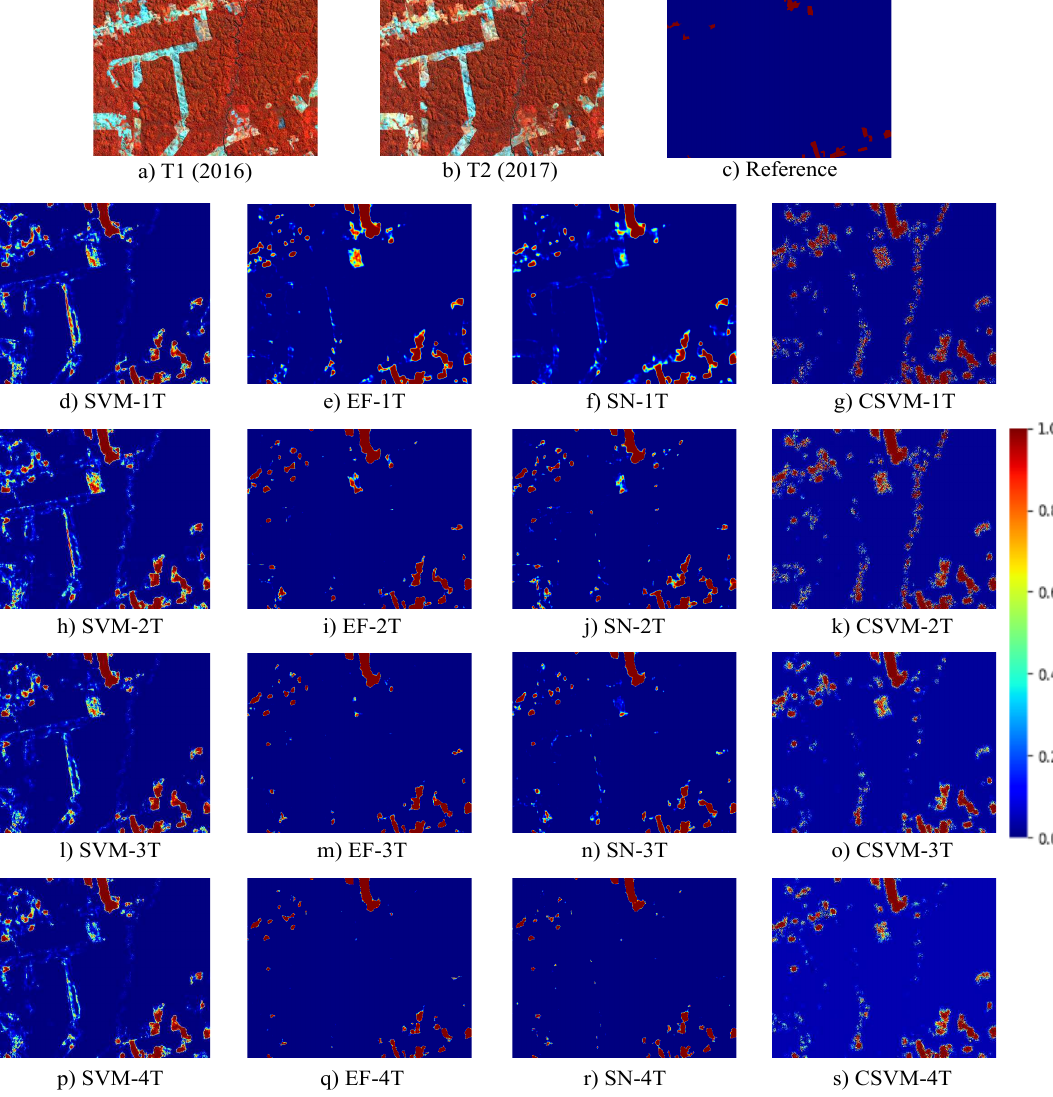
Figure 11. Predicted maps for tile 2 computed by SVM, EF, SN, and CSVM using one, two, three, and four tiles for